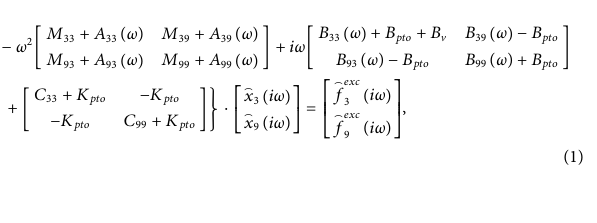
Frontiers in Energy Research |